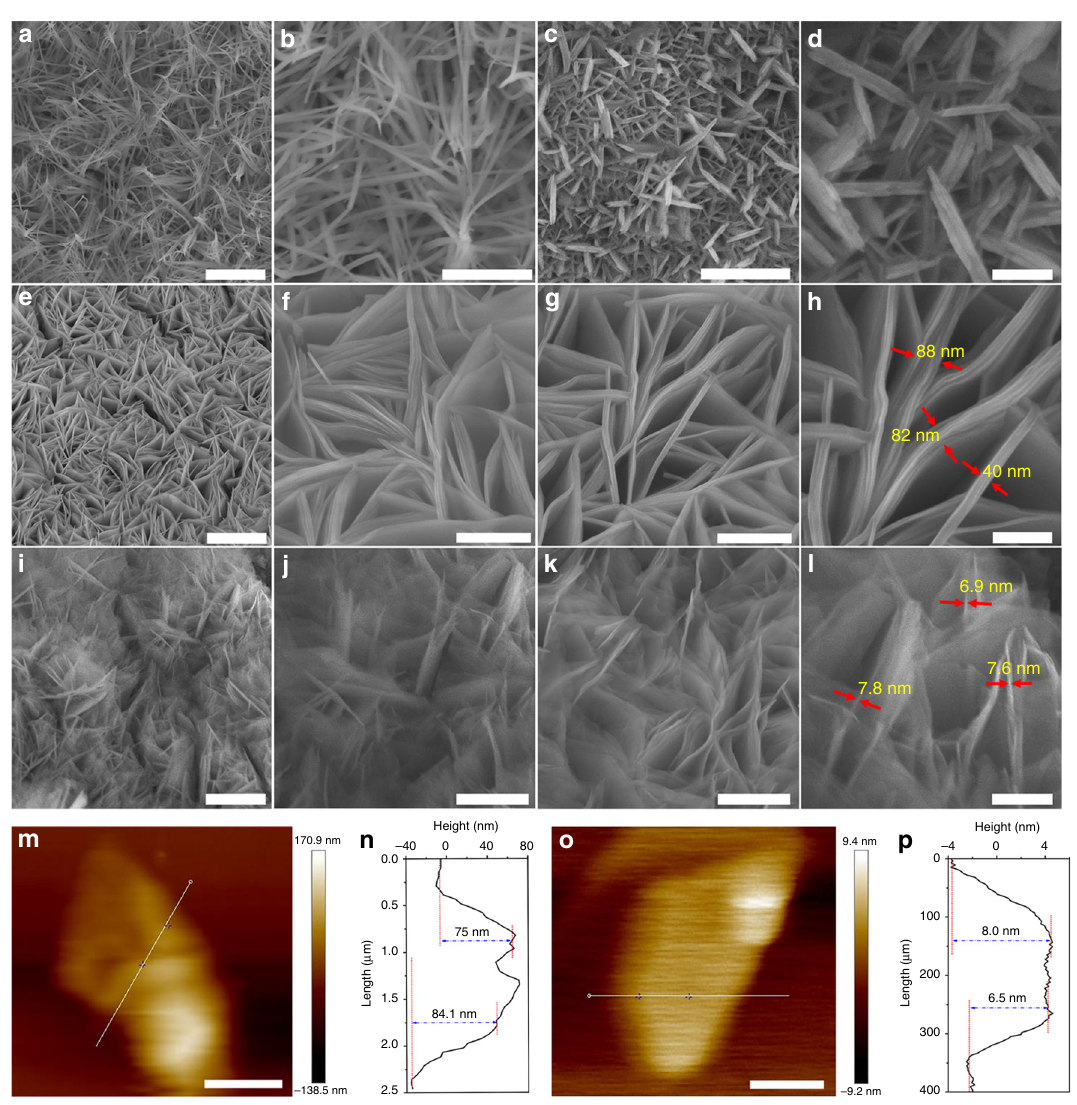
Fig. 2 SEM images of LDH/NF samples. a Low-magni fi cation and b high-magni fi cation SEM images of CLDH/NF. Scale bars: a 2 μ m; b 500 nm. c Low- magni fi cation and d high-magni fi cation SEM images of ILDH/NF (recorded at different areas). Scale bars: c 1 μ m; b 200 nm. e – l SEM images of e – h pristine ICLDH/NF and i – l e-LDH@GDY/NF (recorded at different areas). Scale bars: e 2 μ m; f , g , j , k 500 nm; i 1 μ m; h , l 200 nm. AFM images and height pro fi les of m , n ICLDH nanosheets and o , p e-LDH@GDY nanosheet, respectively. Scale bars: m 1 μ m; o 150